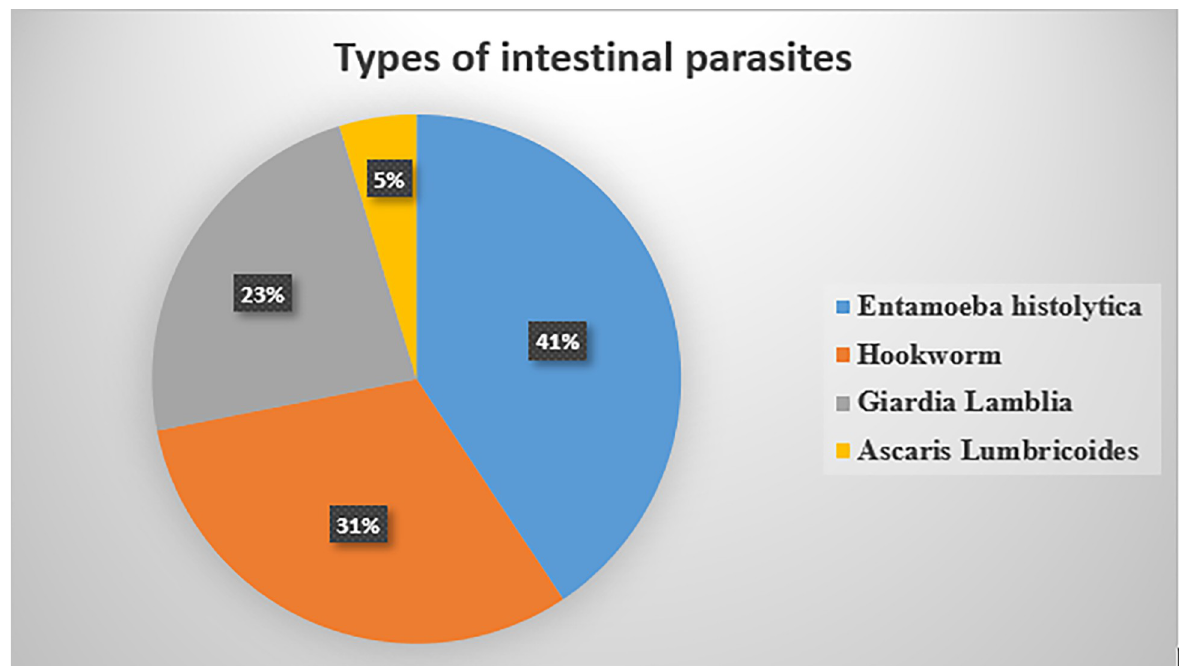
Fig 1. Prevalence and types of intestinal parasites among pregnant women attending antenatal care at Debre Markos Referral Hospital, Northwest Ethiopia, 2016.